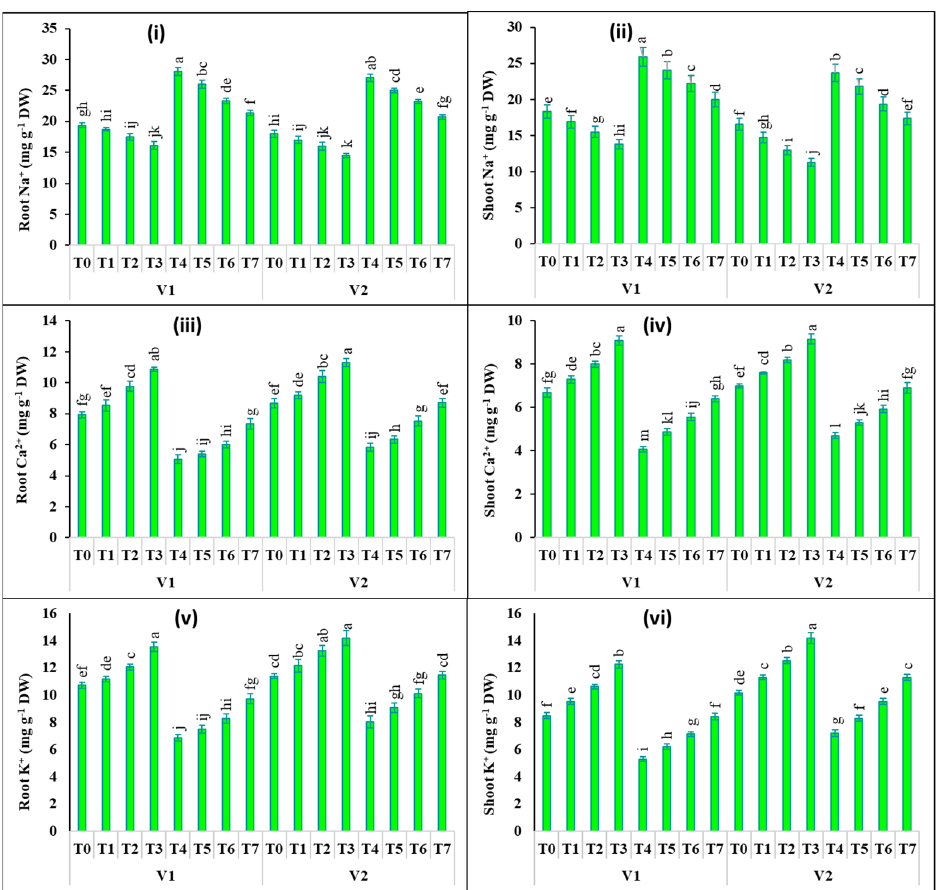
Figure 6. Influence of salicylic acid priming on ( i ) root Na+, ( ii ) shoot Na+, ( iii ) root Ca2+, ( iv ) shoot Ca2+, ( v ) root K+, and ( vi ) shoot K+ content under salt stress; T0 (control), T1 (hydropriming), T2 (10 mM SA priming), T3 (20 mM SA), T4 (170 mM NaCl), T5 (170 mM NaCl + hydropriming), T6 (170 mM NaCl+10 mM SA priming), and T7 (170 mM NaCl+20 mM SA priming); bars sharing same case letter or without lettering, for a parameter, do not significantly differ ( p ≤ 0.05) by the LSD test.